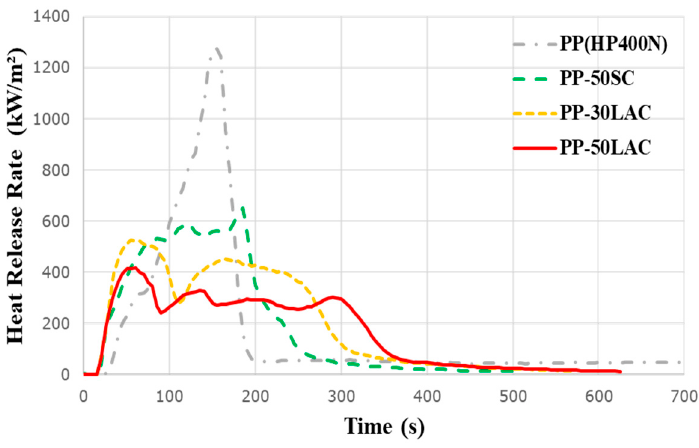
Figure 6. Heat release rate (HRR) curves of neat PP, PP-50% LAC/SC, and PP-30% LAC samples.